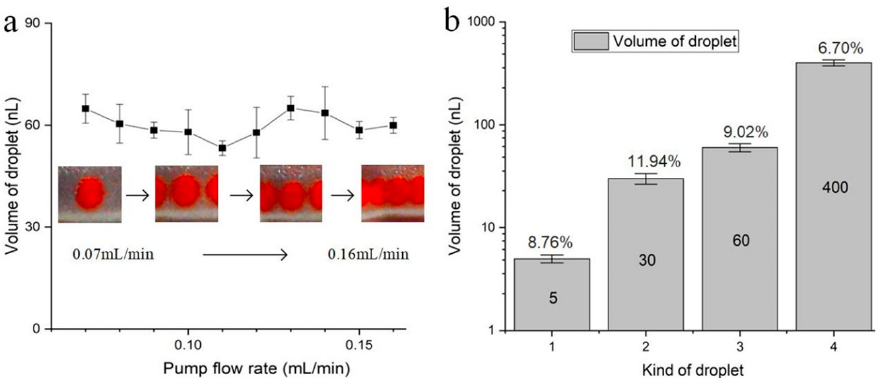
Figure 4. Stability and robustness of droplet size with ranging pump flow rate. ( a ) Shows the droplet volumes were about 60 nL with an increasing flow rate of a mono-pump from 0 mL/min, and ( b ) summarizes the RSD of the volume of four kinds of droplets.